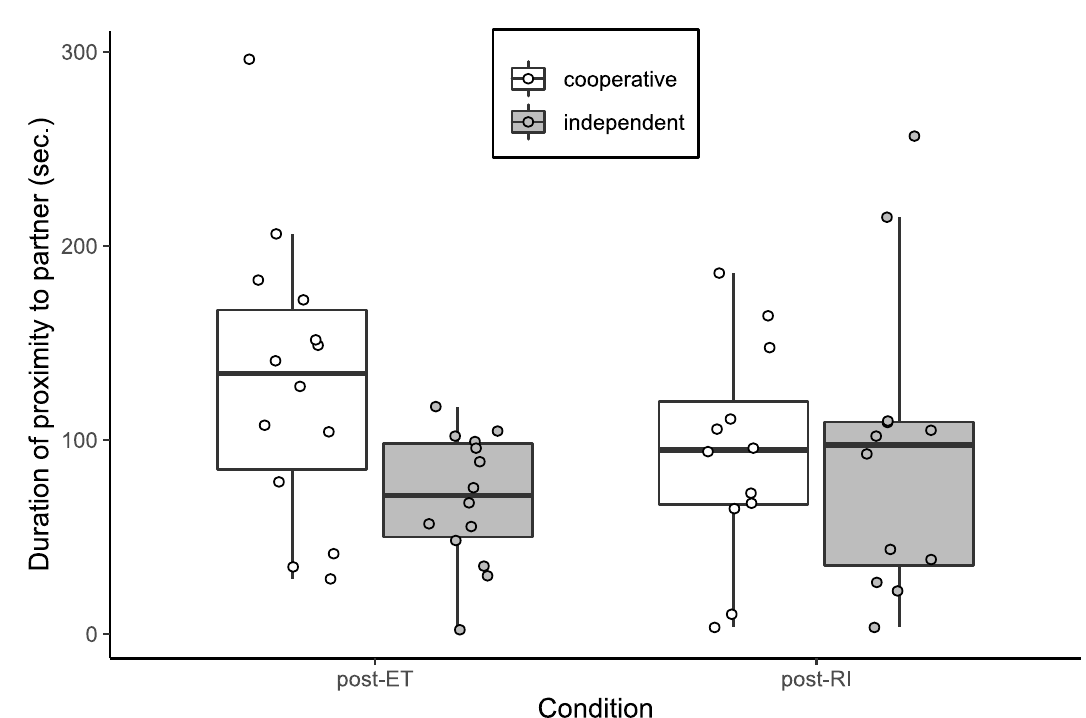
Fig 4. Duration spent in proximity to the conspecific partner (sec.) in the interaction session after the two social conditions of the paw task, for cooperative worker (N = 12) and independent worker (N = 12) breeds. Boxes display the interquartile range, black horizontal bars represent the median, whiskers represent the range of data points within 1.5 times the interquartile range from the upper and lower hinge, and circles represent individual data points. ET, equity; RI, reward inequity.